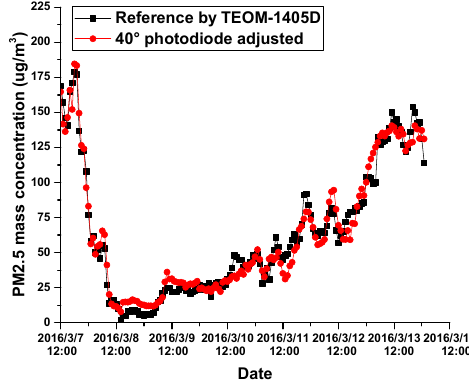
Figure 14. Comparison of 1-h average PM2.5 mass concentrations obtained simultaneously using a TEOM 1405-D monitor at Wolongqiao monitoring station and adjusted PM2.5 mass concentrations based on the 40° photodiode in the particle sensor according to different weather indices (the regression results are presented in Figure 13b, center plot).